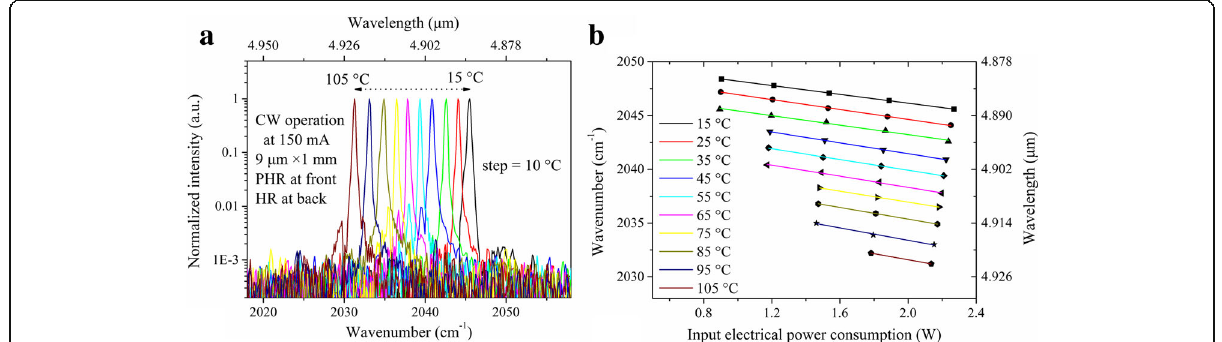
Fig. 4 a CW lasing spectra of the 1-mm-long PHR and HR-coated DFB QCL at 150 mA with different heat sink temperatures and b CW lasing wavenumber as a function of input electrical power-consumption and heat sink temperature